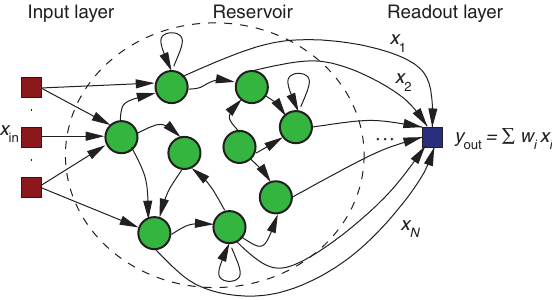
Figure 1: Standard layout of a reservoir computer, comprising an input layer (red), the reservoir (green) with randomized but fixed connections, and the linear readout layer (blue). Here, for simplicity a one-dimensional readout layer is drawn ( l =